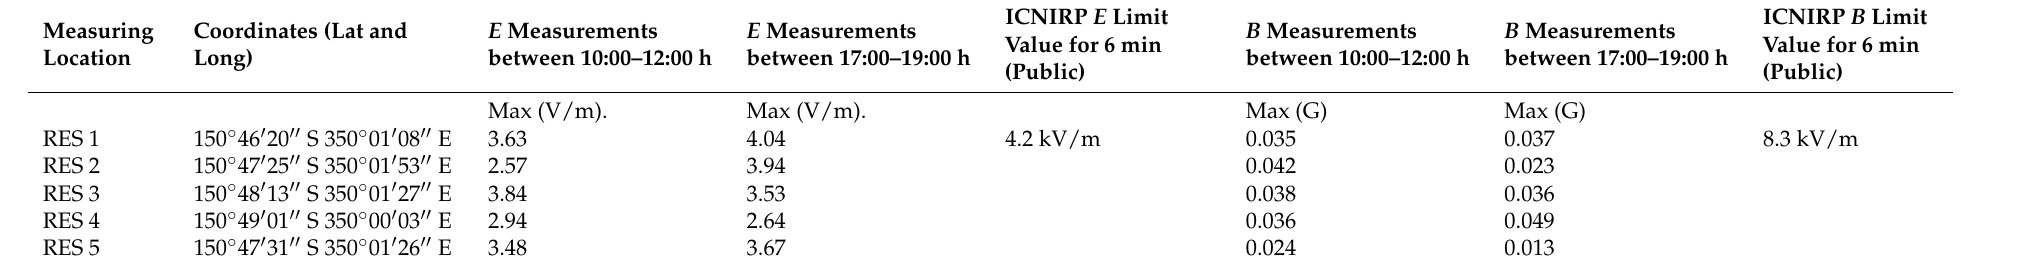
Table 8. Statistical results of E and B in residential areas.